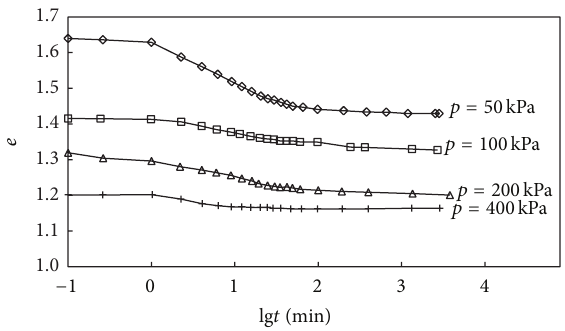
Figure 3: Tested 𝑒 -lg 𝑡 curves of soft soil sample No. 2.